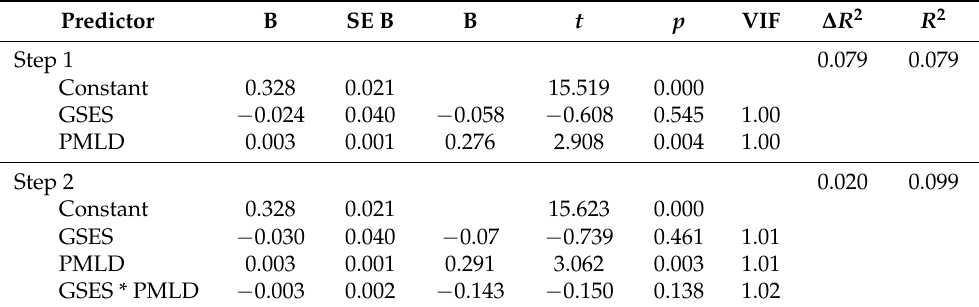
Table 3. Hierarchical regression analysis on predictors and moderator for general mental health